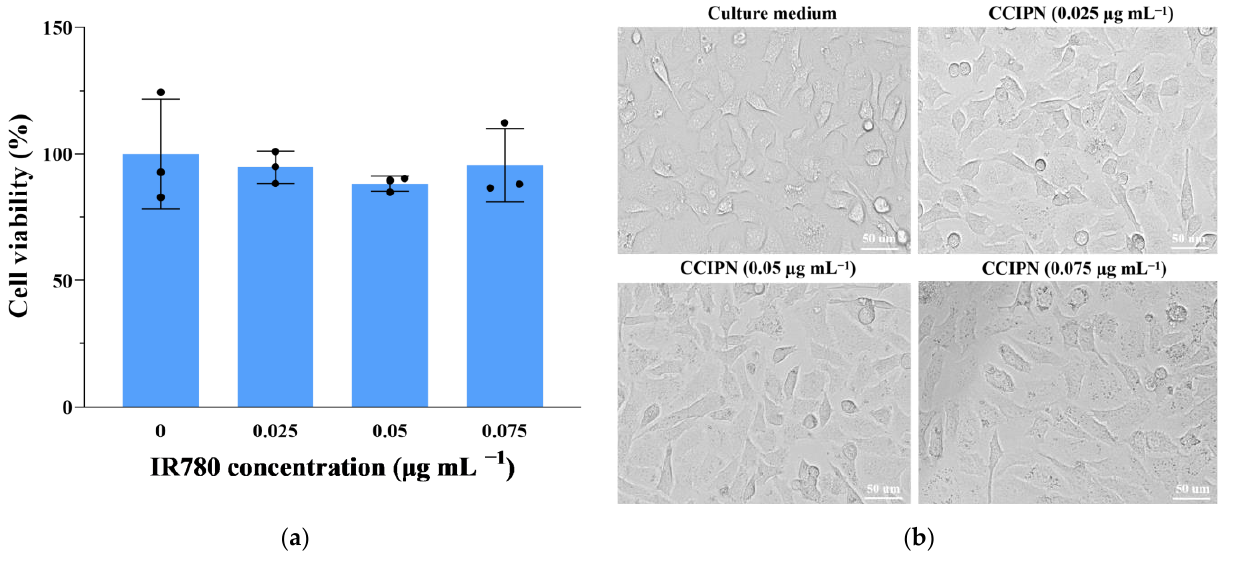
Figure 9. ( a ) Viability of DU145 prostate cancer cells after incubation with various concentrations of CCIPNs (IR780 concentration 0, 0.025, 0.05, and 0.075 μg mL − 1 ) for 24 h in the dark. ( b ) Morphologies of DU145 prostate cancer cells after incubation with various concentrations of CCIPNs (IR780 concentration 0, 0.025, 0.05 and 0.075 μg mL − 1 ) for 24 h in the dark. Values are expressed as mean ± SD (n = 3). Each dot represents an independent experiment.